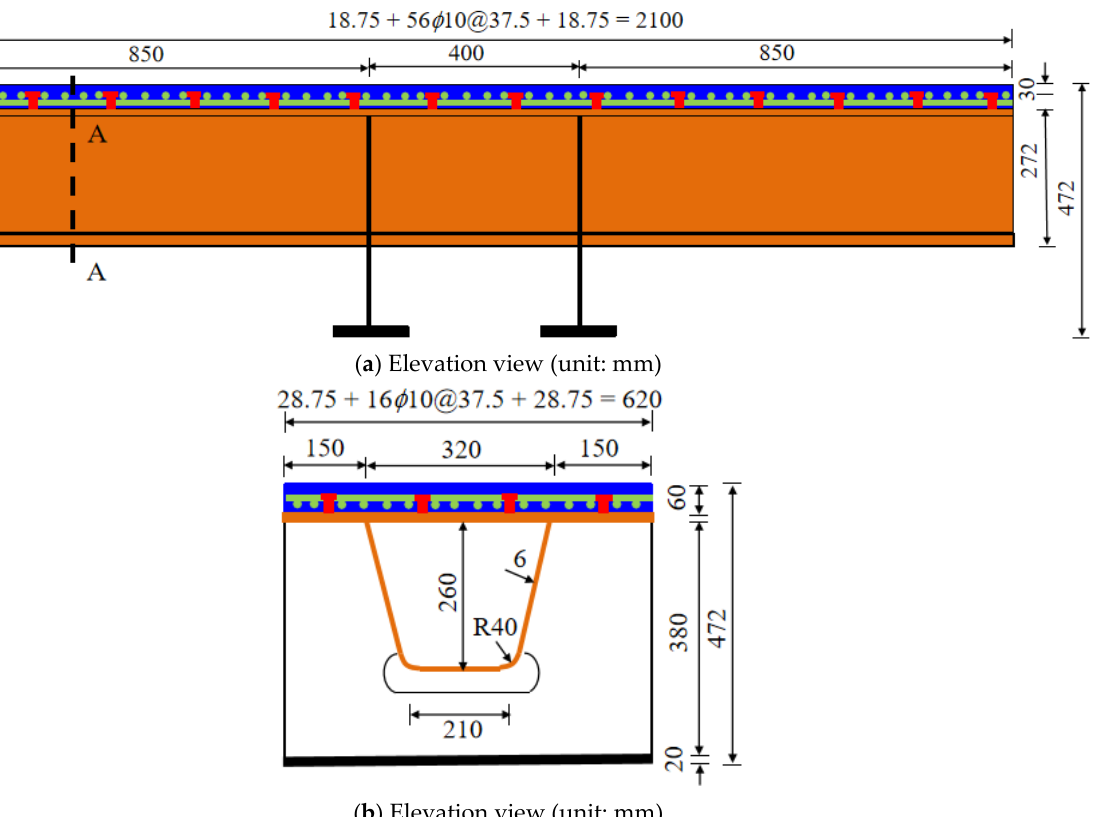
Figure 7. Details of steel-UHPFRC composite beam (take U155-60-25-16 as an example).